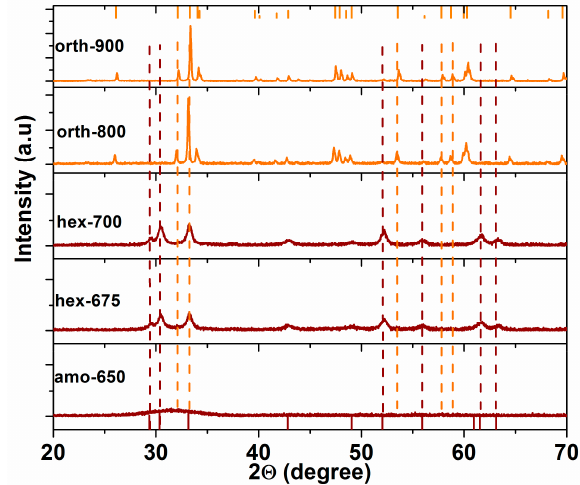
Figure 1. XRD patterns of YFeO 3 calcined at different temperatures. The peak positions in reference diffraction patterns of the hexagonal (ICDD-00-048-0529) and orthorhombic (ICDD-00-011-0558) YFeO 3 are also indicated by gray and black lines, respectively.